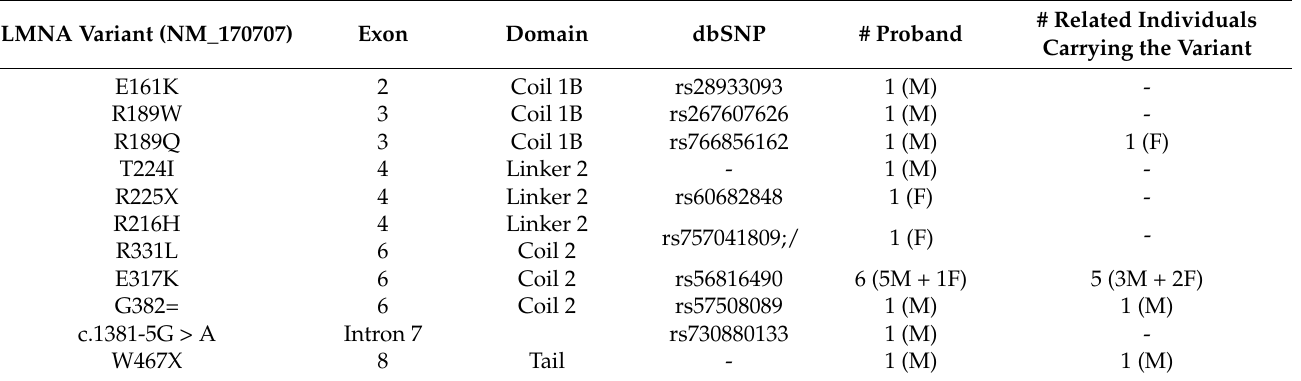
Table 1. LMNA gene variants identified in this